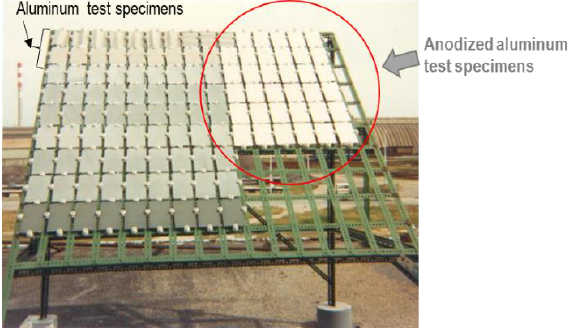
Figure 1. General view of one of the exposure racks (e.g., at the Barreiro test site) after installation.